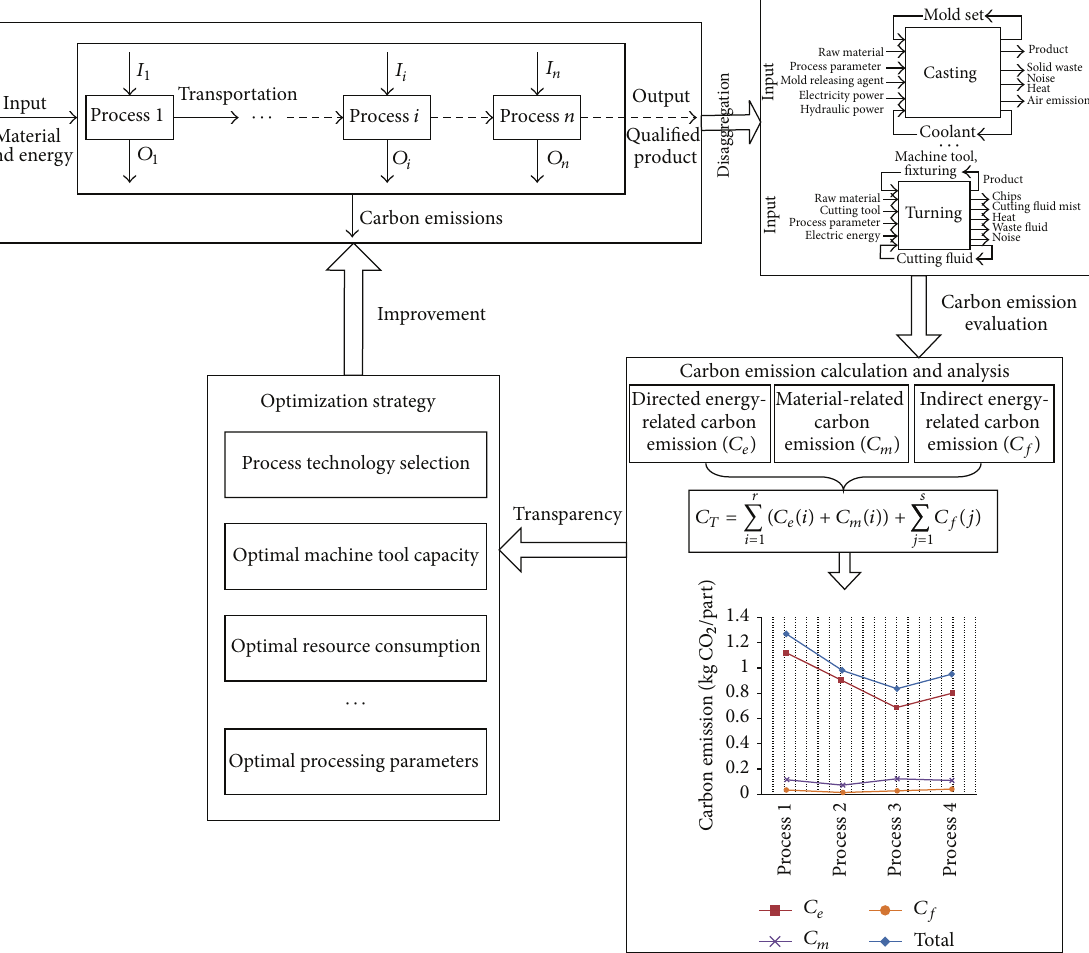
Figure 3: Carbon emission evaluation based optimization